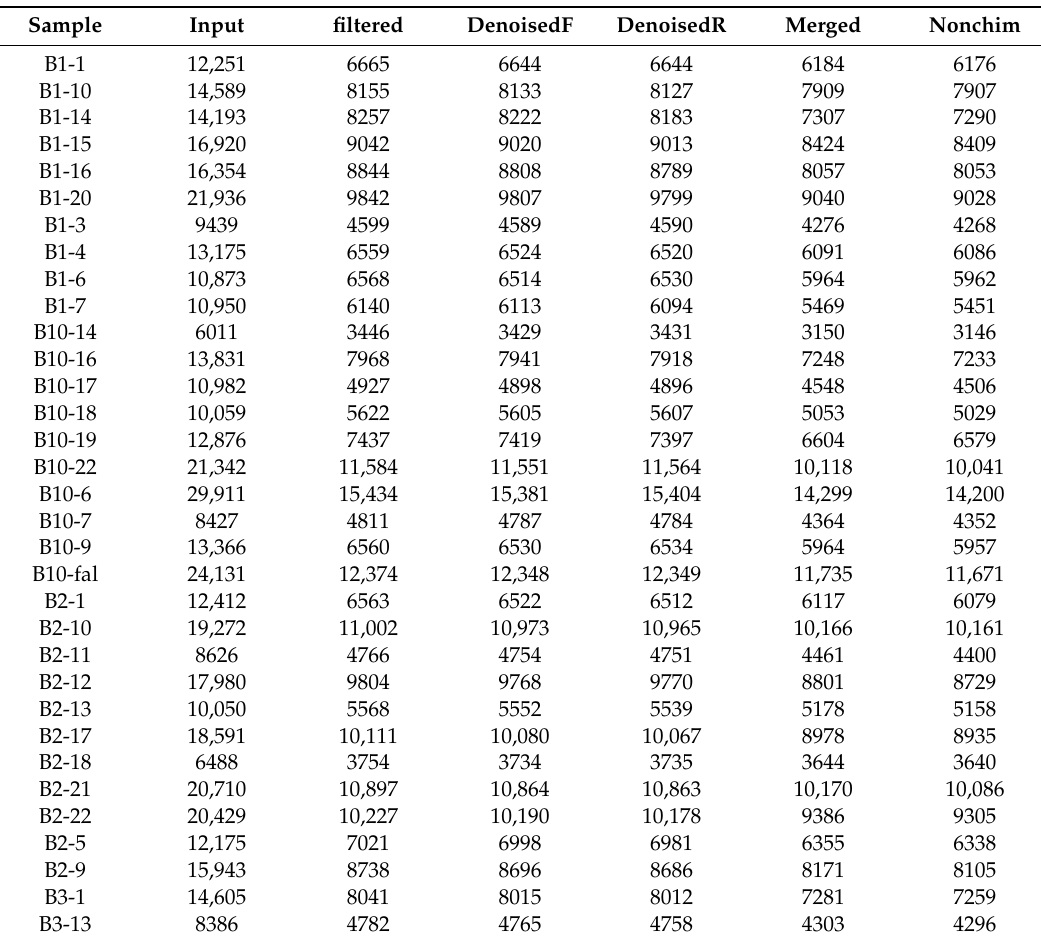
Table A3. Number of reads retained at each step in the DADA2 pipeline. Samples are shown with the block number first followed by the treatment number separated by a hyphen. Numbers 1–4 are white yarrow, Holboell’s rockcress, silky lupine, and bluebunch wheatgrass, respectively, while 11 is all native. Numbers 12–15 are white mustard, buckwheat, wheatgrass, and crimson clover, respectively, while 22 and 23 are all cultivar and fallow, respectively. From left to right are the initial read counts (input), reads after filtering (filtered), forward reads after denoising (denoisedF), reverse reads after denoising (denoisedR), number of reads after merging (merged), and number of reads after chimera removal (nonchim). Denoising and filtering were completed with R statistical software.